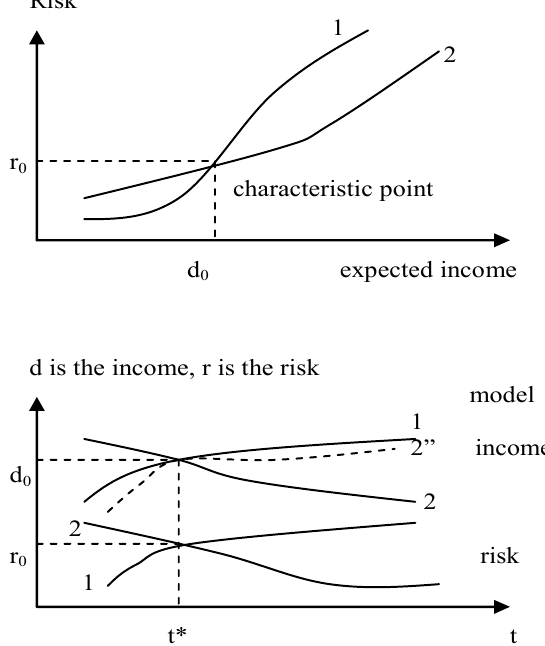
Figure 3. Changes in risk and expected income under the income maximization model (1) and risk minimization model (2).